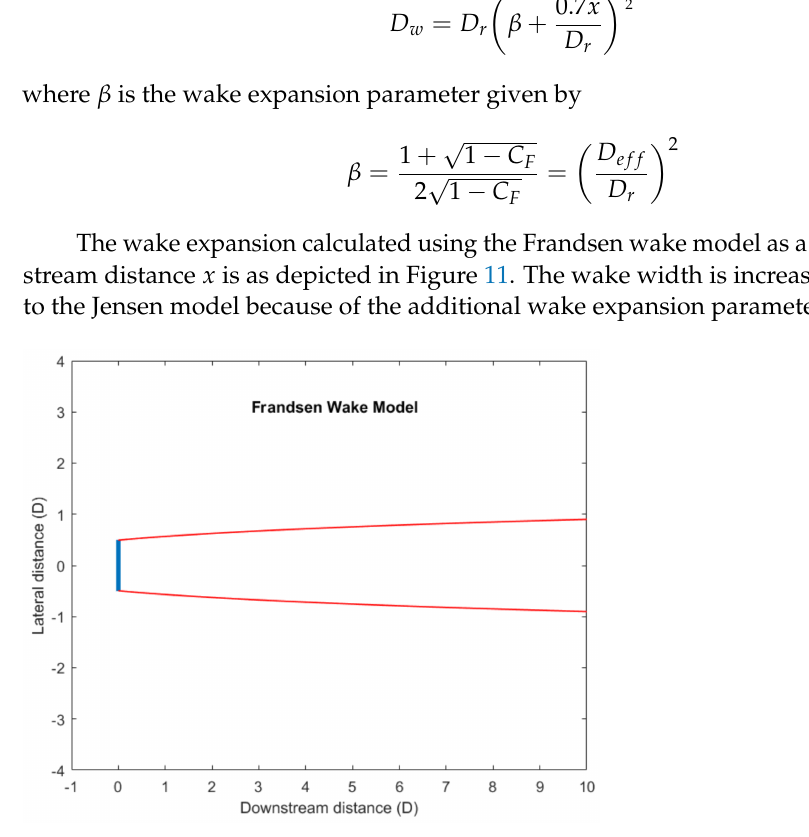
Figure 11. Frandsen wake model implemented in